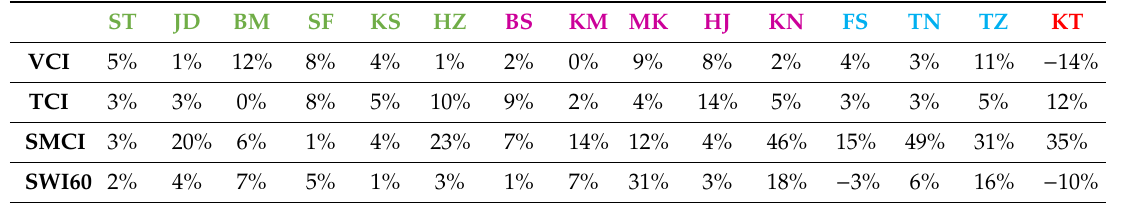
Table 7. Improvement in the maximum correlation coe ffi cient obtained between yields and the drought indices integrated over the phenological stages with regard to the monthly scale. Colors correspond to the four groups of agricultural provinces (see